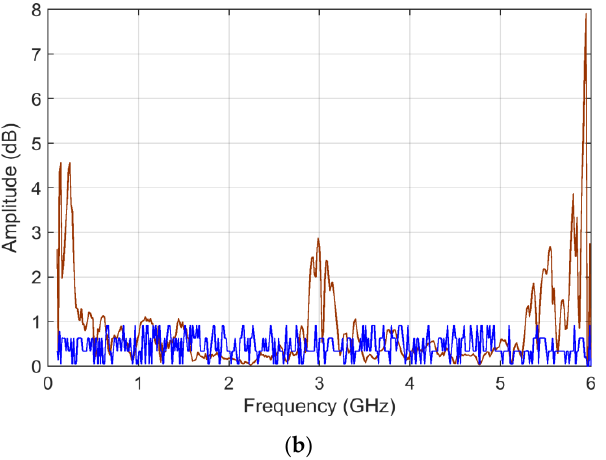
Figure 13. S 11 input data in logarithmic scale: ( a ) ADM i and ( b ) FDM i sensitivity curves, comparing analytical first-order derivative calculation (blue) and normalized standard deviation of MCM output (brown).